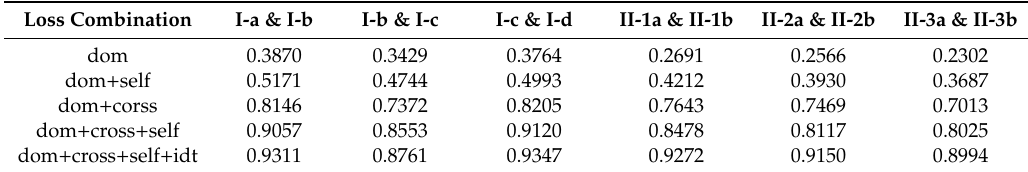
Table 4. Ablation studies of the full objective for our six